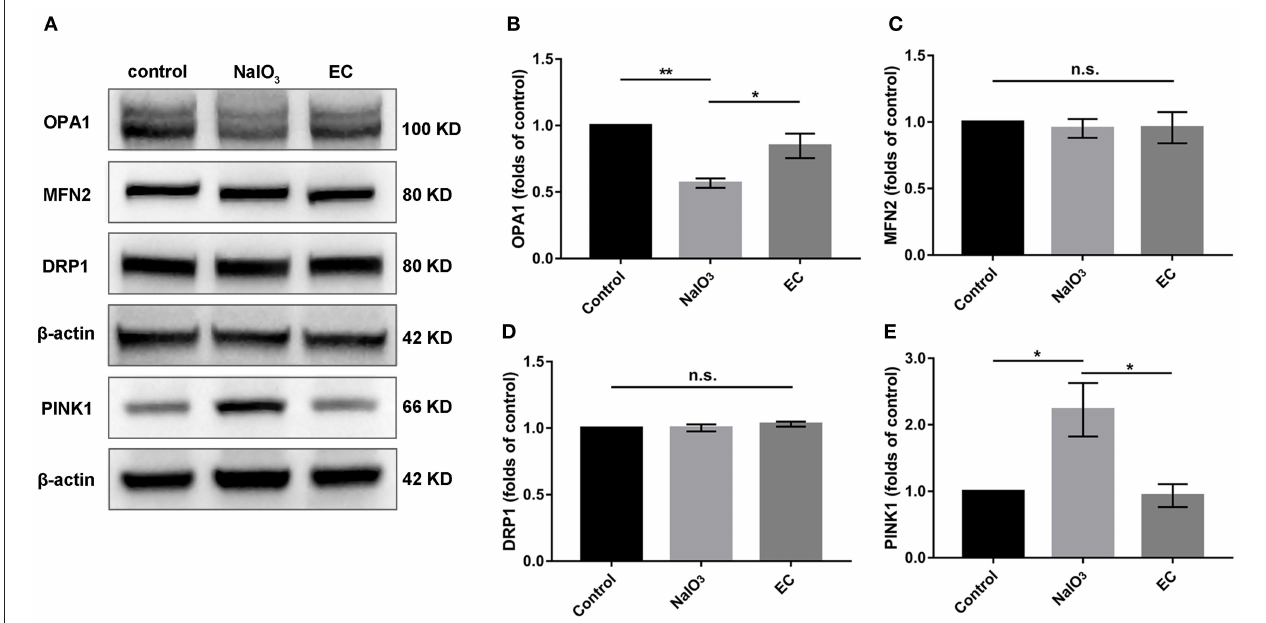
FIGURE 8 | Expression of mitochondrial quality control related proteins after EC and NaIO 3 co-treatment. (A) Key proteins responsible for mitochondrial fission and fusion, and mitophagy-related proteins PINK1 were measured by Western blot. (B) Corresponding quantification of the relative expression of OPA1 demonstrated an enhancement with EC treatment, but no significant changes were found in (C) MFN2 and (D) DRP1. (E) Quantification analysis showed that the increase of PINK1 was lower with EC treatment. Values are presented as mean with SEM; n = 4; n.s., no significance. * p < 0.05, ** p <